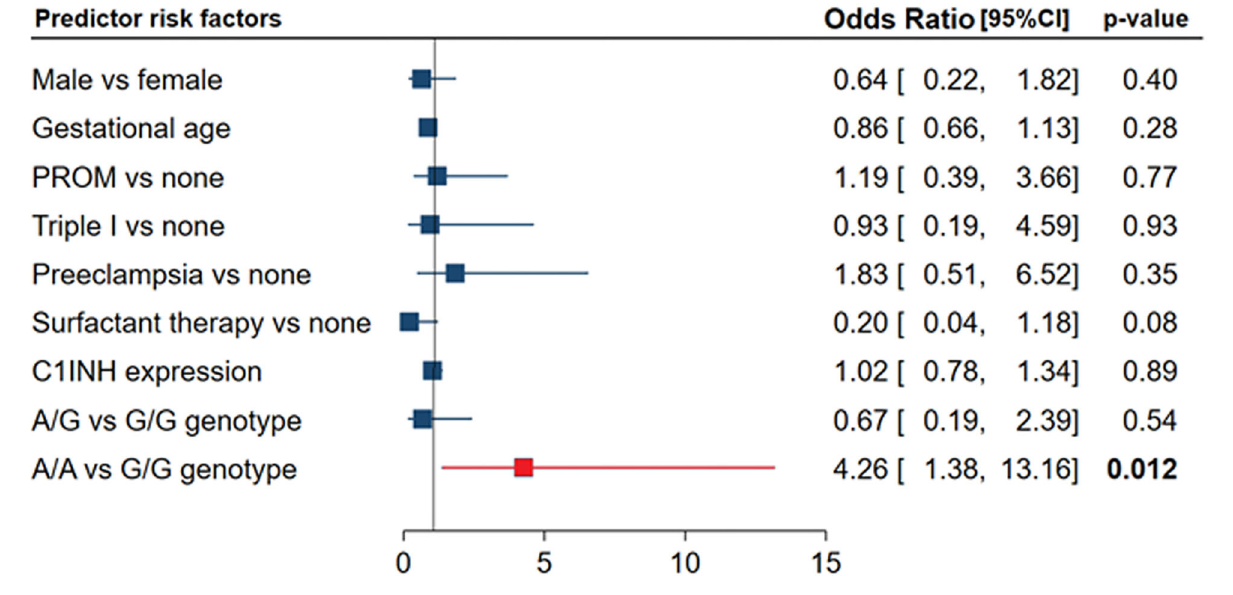
FIGURE 4 | Independent risk factors for developing sepsis in neonatal lung disease patients. Logistic regression analysis was applied. Data are reported and plotted as odds ratio and 95% confidence interval (CI). PROM, Premature rupture of membrane. Data showed homogeneity of the mutant allele (A allele) was associated with four times more risk of developing sepsis ( p =